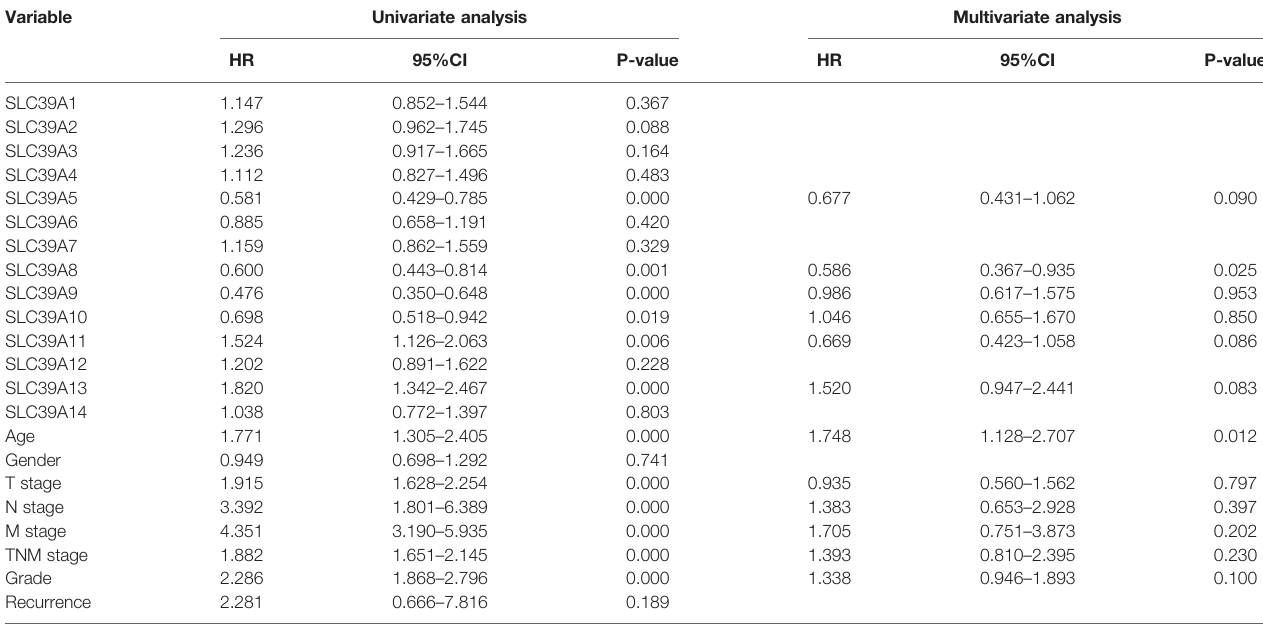
TABLE 1 | Univariate and multivariate analyses of ZIP family genes mRNA level and patient overall survival. Variable